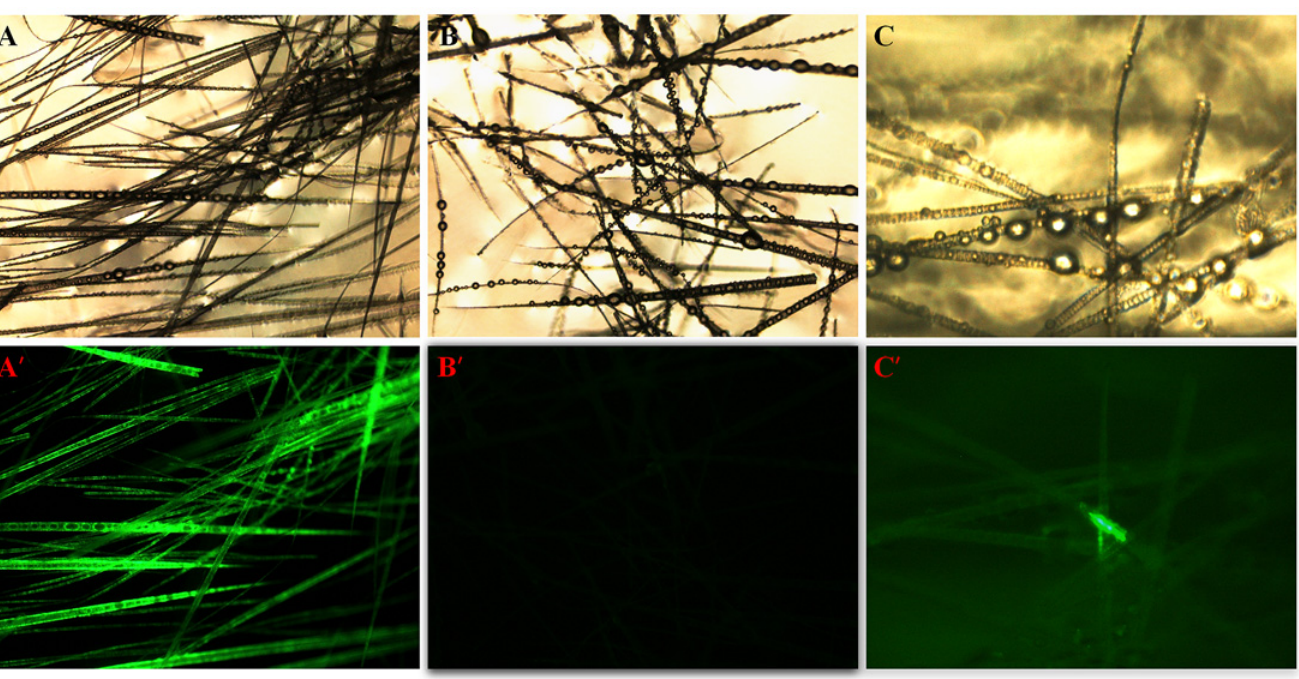
Fig 4. Expression of ZsGreen1 in sheared dorsal hair from a transgenic mouse. The hairs of the mice were examined under a fluorescence microscope. The upper and lower images were observed under white and fluorescent light, respectively. (A, A') The hair of the KRTAP11-1-ZsGreen1-positive mouse. (B, B') The hair of the negative control (NC) mouse. (C, C') The hair of the KRTAP3-3-ZsGreen1-positive